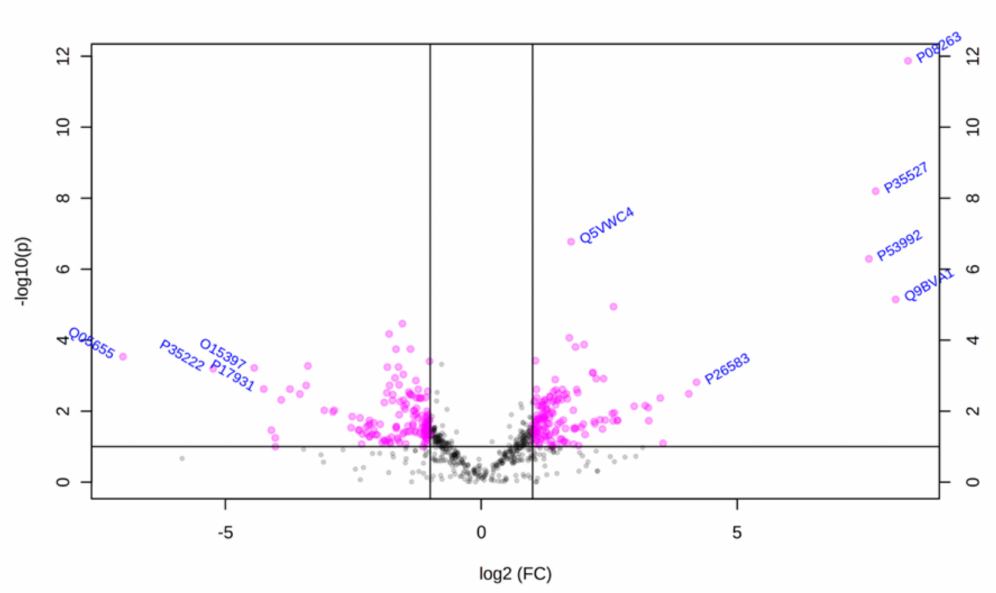
Figure 3. Volcano plot of fibroblasts proteins isolated from the skin of psoriatic patients ( n = 5) and healthy controls ( n = 5). Red dots indicate proteins of statistical significance among the groups tested. The p- values and the fold change (FC) for each protein are included in Supplementary Table